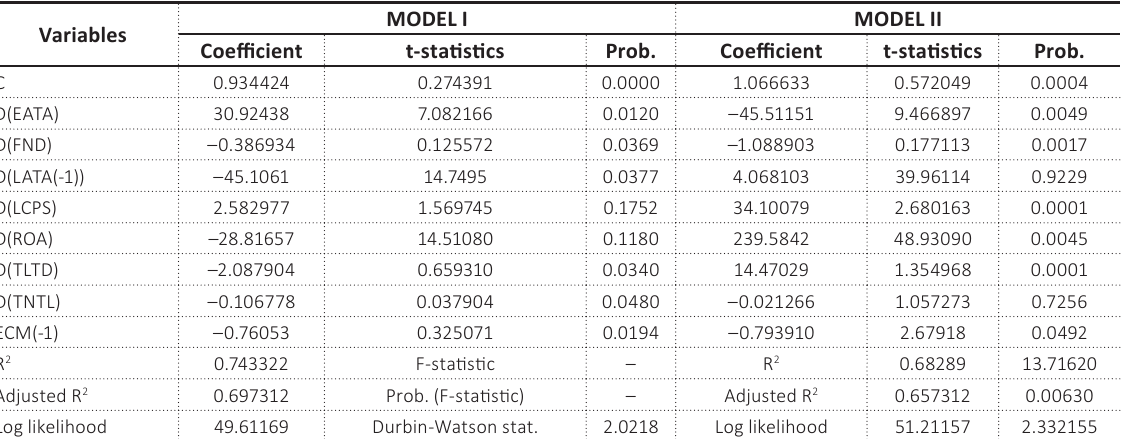
Table 7. Short-run tests: Model I and II